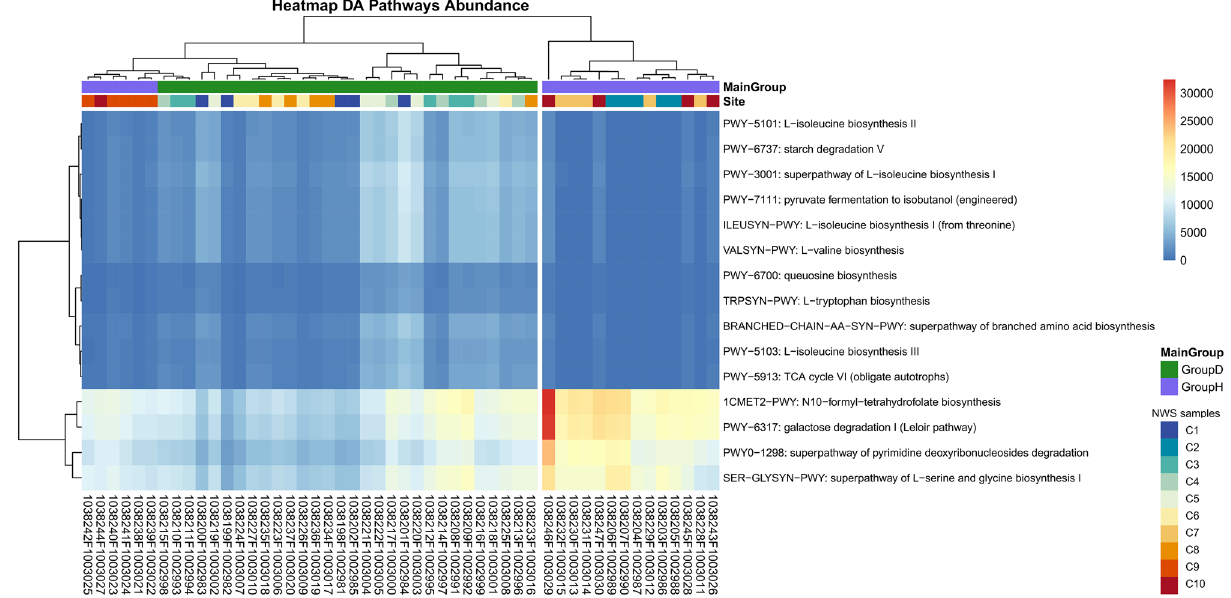
Figure 6. Functional heatmap. Hierarchical clustering heatmap visualized with pheatmap R package v.1.0.12 shows samples in columns and the 15 most characterizing MetaCyc pathways in rows. The PICRUSt2- predicted abundance levels are represented by the background color, where blue means low and red means high abundance. The main experimental conditions are shown in green and violet, representing NWS type-D and NWS type-H, respectively.